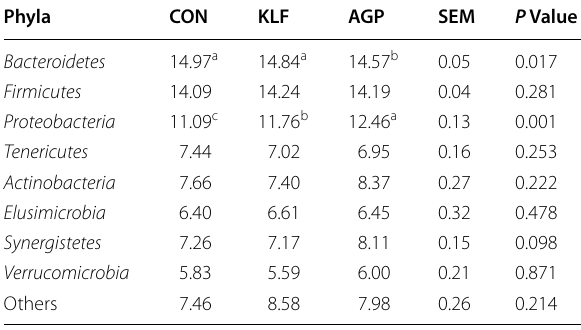
Sequences relative abundances were transformed using log2 SEM standard error of the mean; CON control treatment; KLF kudzu-leaf flavonoids supplement treatment; AGP the antibiotic supplement (Aureomycin) treatments a,b Within rows and with different letters differed significantly (P < 0.05)